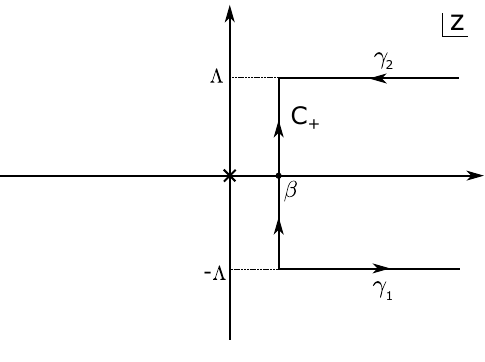
Figure 8 . Contour deformation for G +